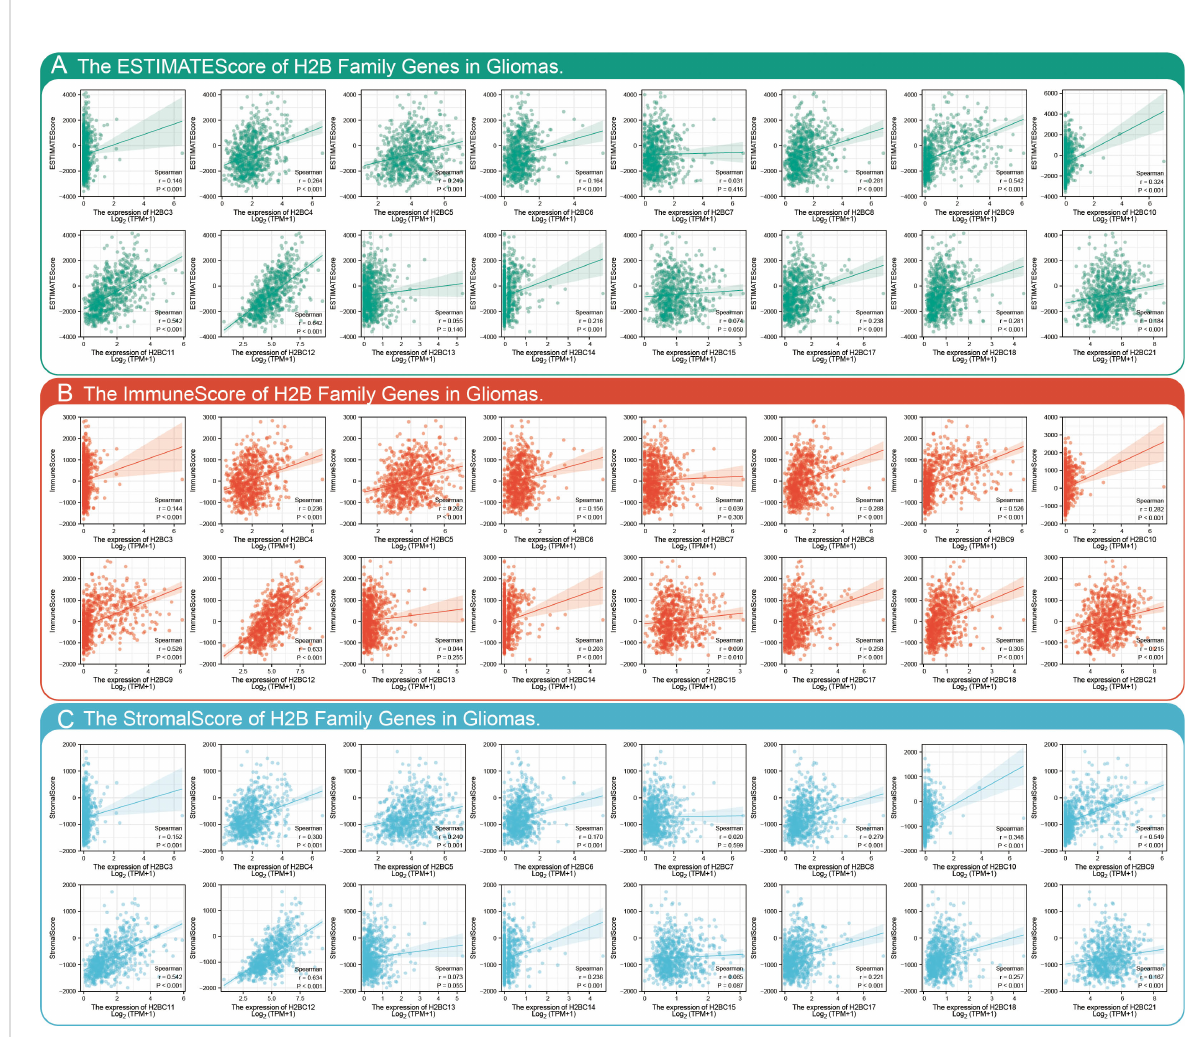
FIGURE 8 Combining STROMALScore, ImmuneScore, and ESTIMATEScore to evaluate the relationship between H2B gene expression and tumor immune cell in fi ltration. Immune score of H2B genes in glioma based on the (A) STROMALScore, (B) ImmuneScore, and (C) ESTIMATEScore